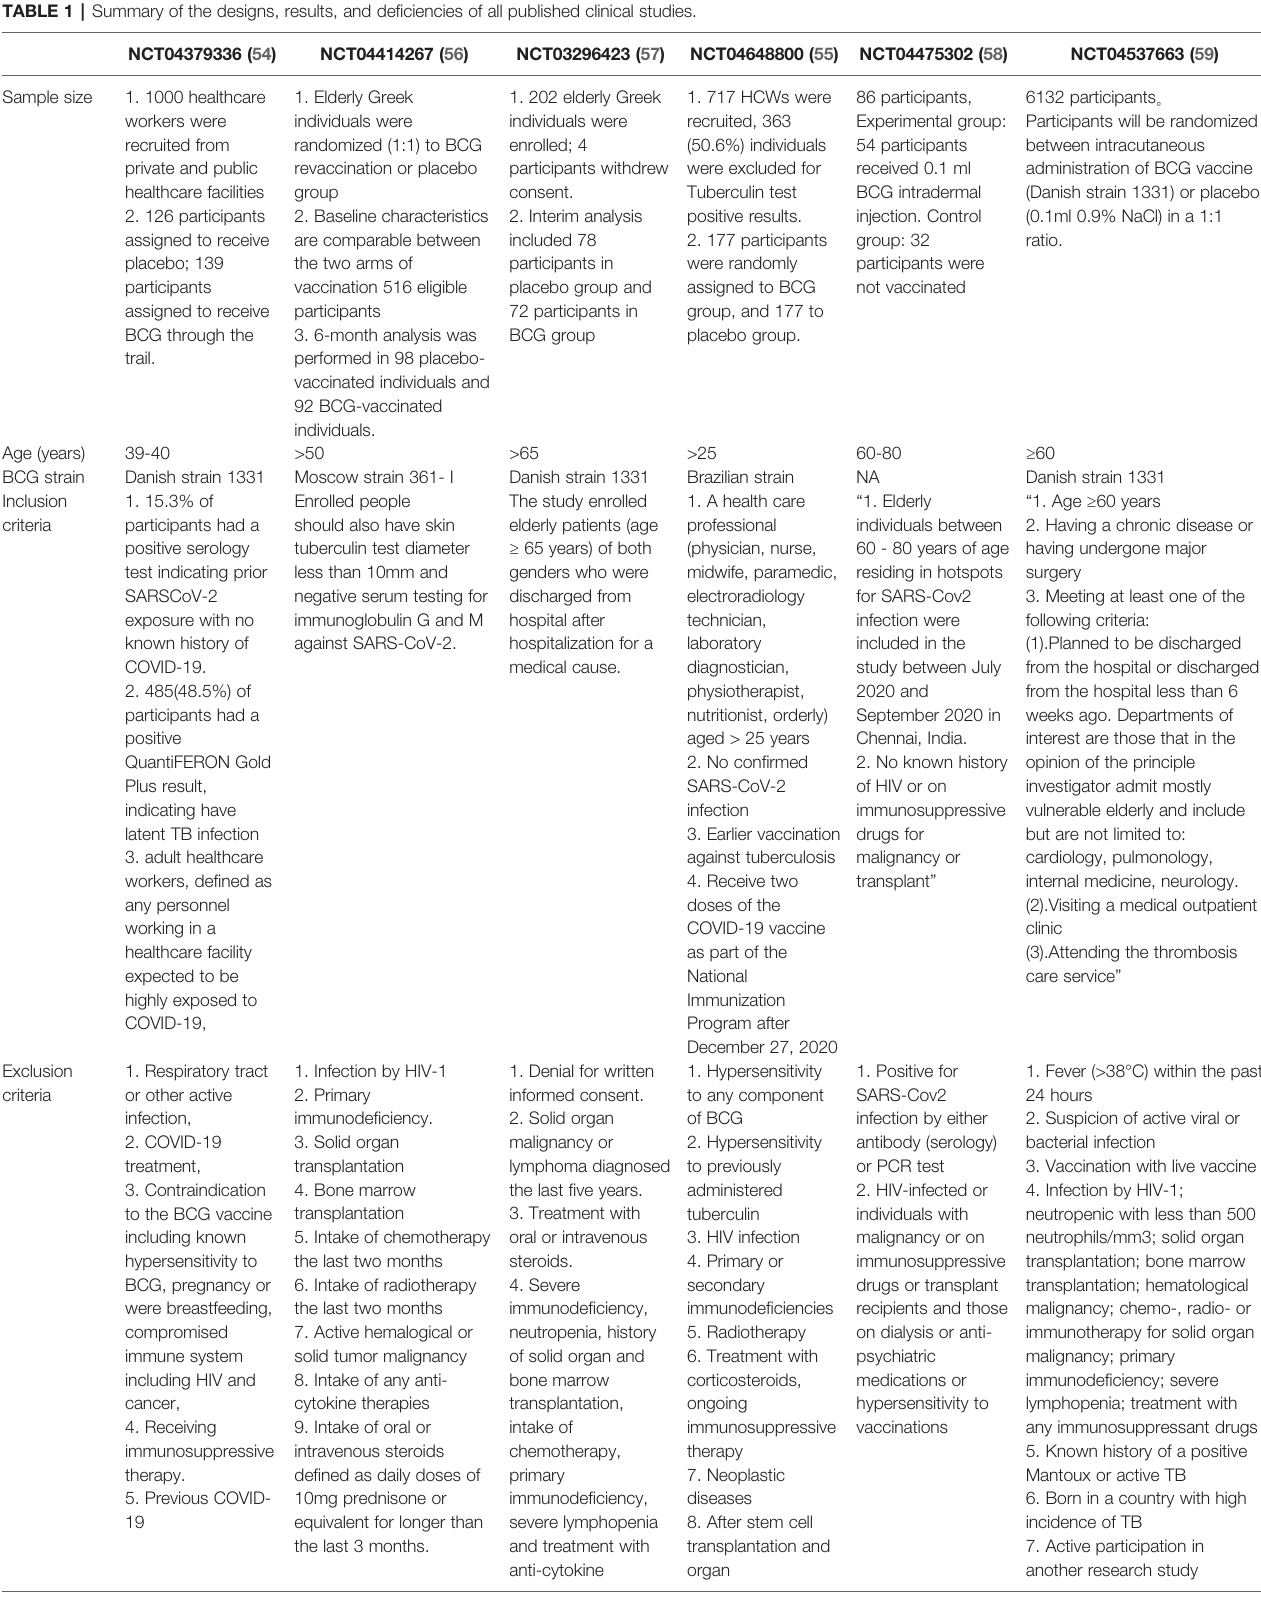
TABLE 1 | Summary of the designs, results, and de fi ciencies of all published clinical